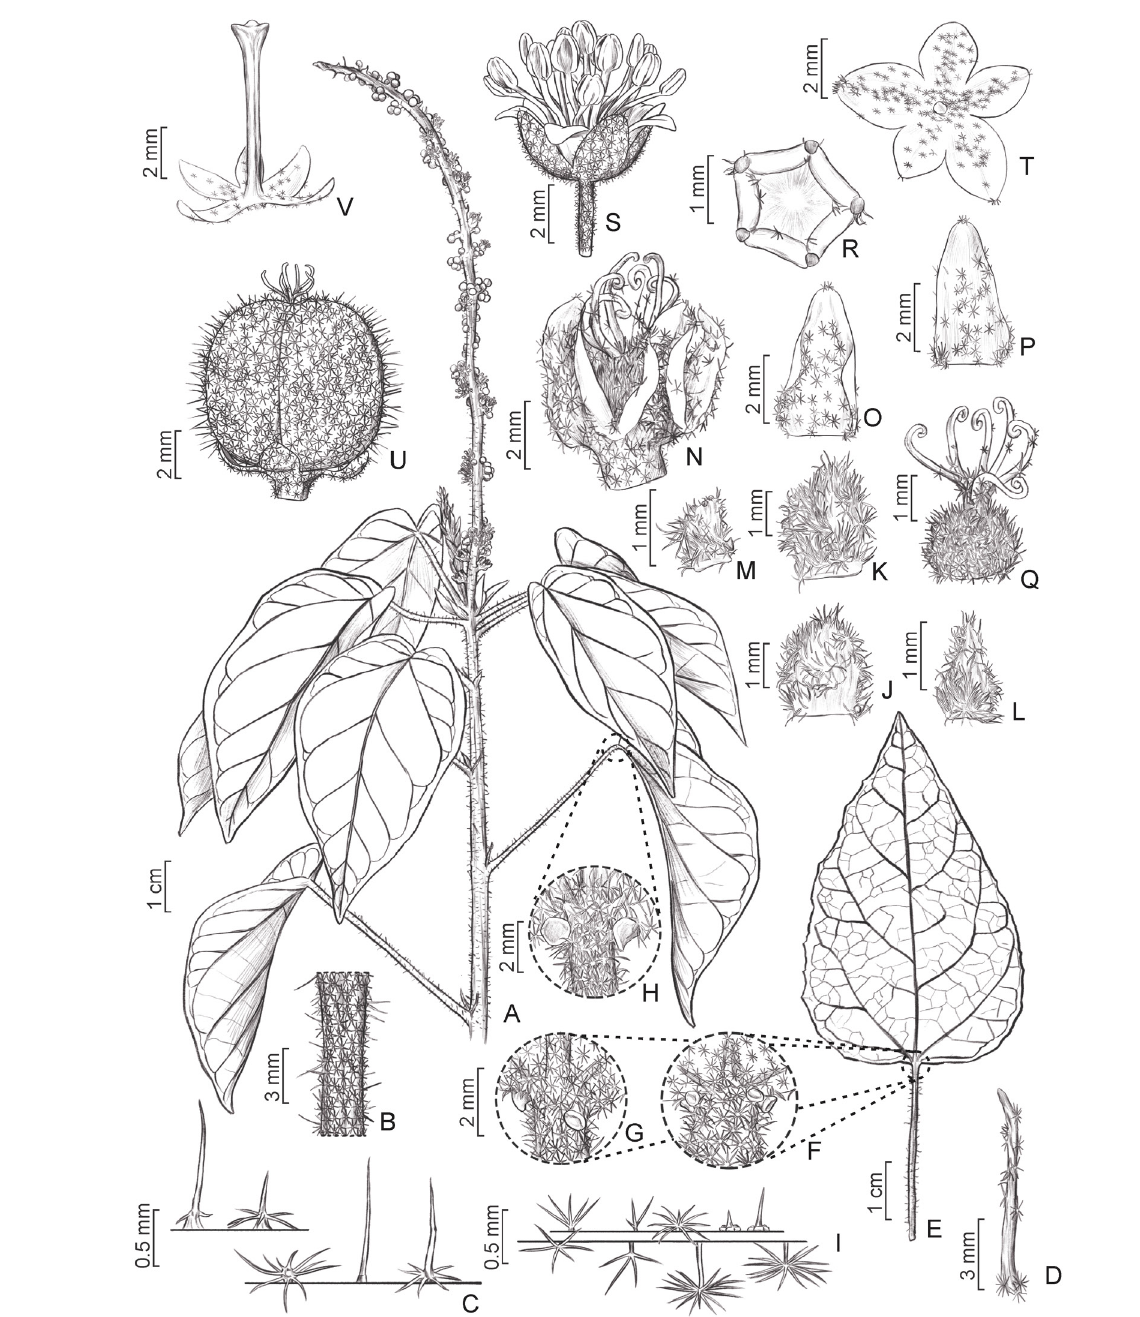
Fig. 2. Croton restingae Sodré & Riina sp. nov. A . Flowering branch. B . Indument of branch. C . Trichomes of branches. D . Stipule. E . Leaf. F–G . Foliar base (adaxial surface) showing the nectaries. H . Foliar base (abaxial surface) showing the nectaries. I . Trichomes of adaxial and adaxial surfaces of the leaf blade. J . Pistillate bract, dorsal surface. K . Pistillate bract, ventral surface. L–M . Pistillate bracteoles, dorsal surface. N . Pistillate flower. O . Pistillate sepal, dorsal surface. P . Pistillate sepal, ventral surface. Q . Gynoecium. R . Nectary disk of pistillate flower and glandular petals. S . Staminate flower. T . Calyx of staminate flower, dorsal view. U . Capsule. V . Carpophore showing the columella with discrete appendages at the apex. Drawn by Renato Galhardo Neto. A–R, T from M.F. Vasconcelos s.n. ; S from J. Fontella 2899 ; U from s.col. s.n. R[99957]; V from A. Souza et al. 3163